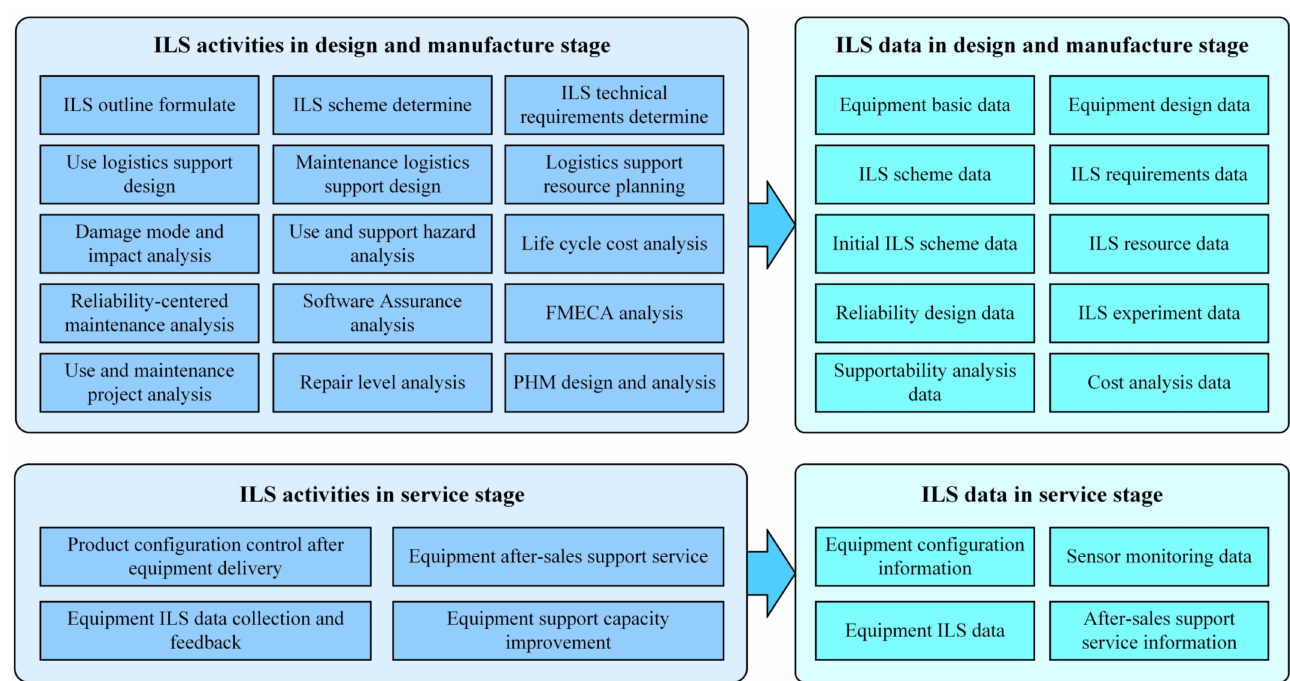
Figure 1. Equipment lifecycle ILS activities and data elements.